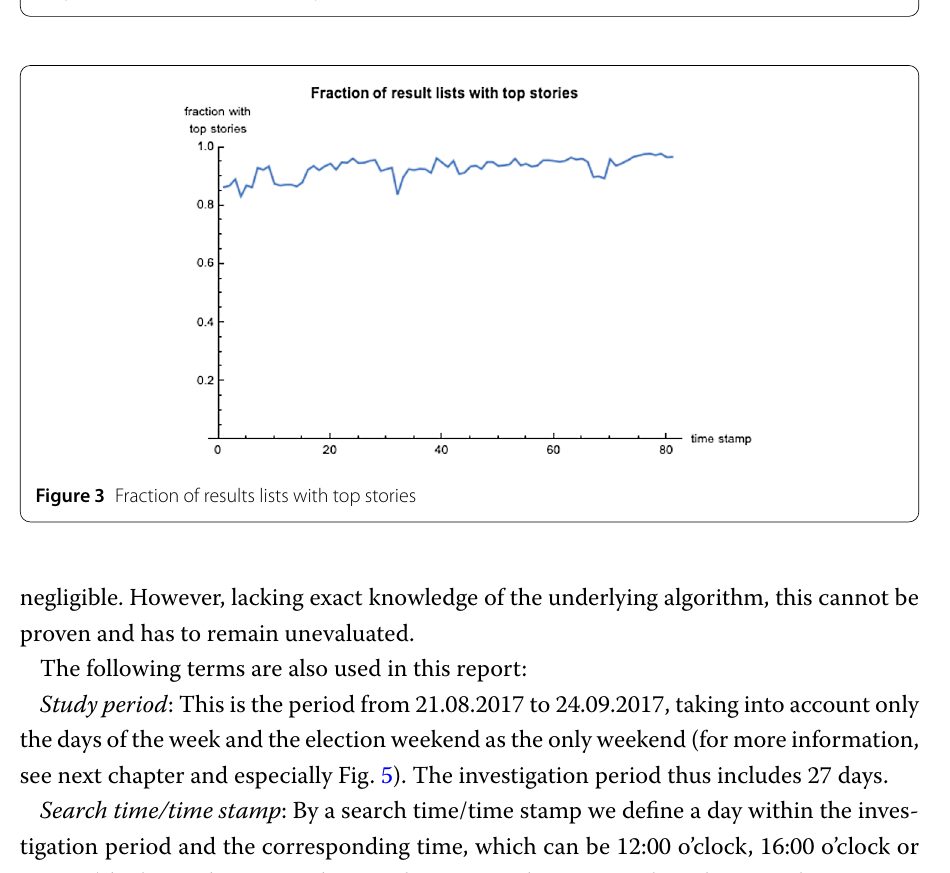
Figure 2 Chronological sequence of the search terms “Katrin Göring-Eckardt” and “Dietmar Bartsch”. The Google Trends diagrams clearly show the increase in search occurrences for the search terms due to the plug-in, which was unlocked on July 7th